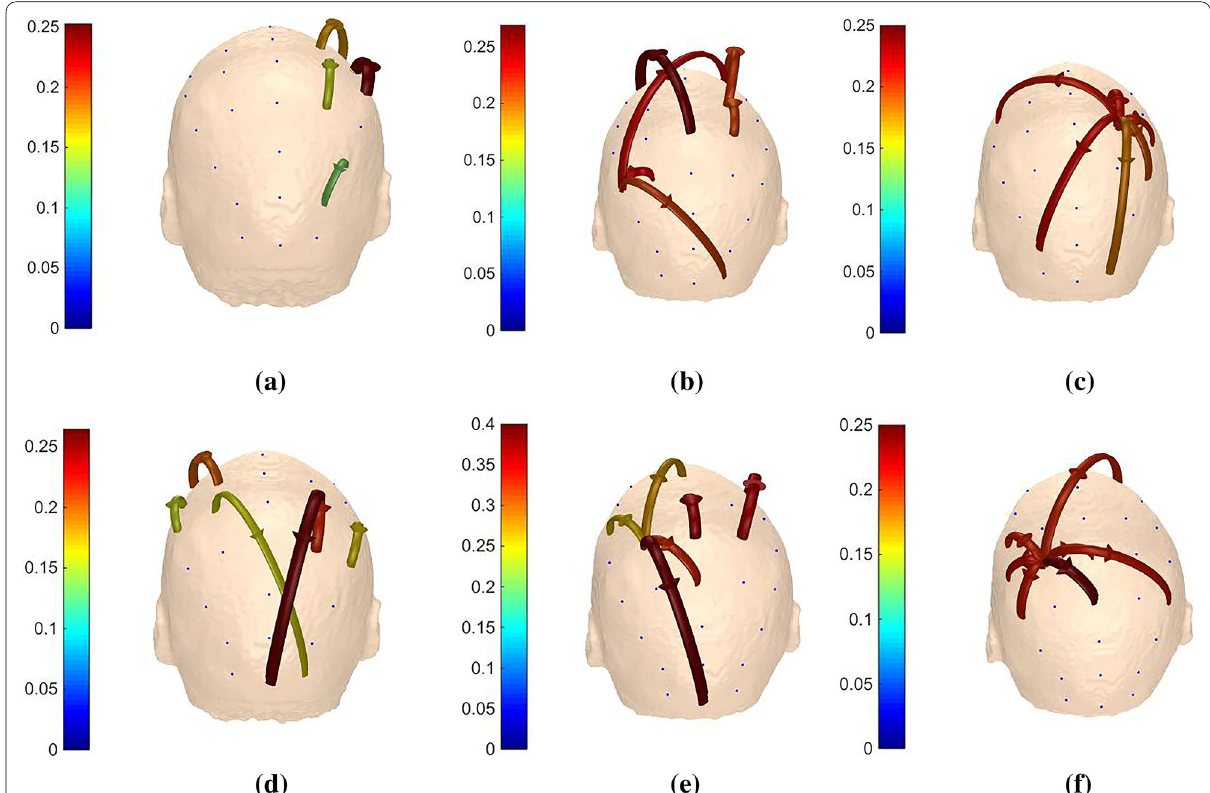
Fig. 9 BFNs of ‘k3b’ in α frequency band a m m 3 for ‘RH’ =